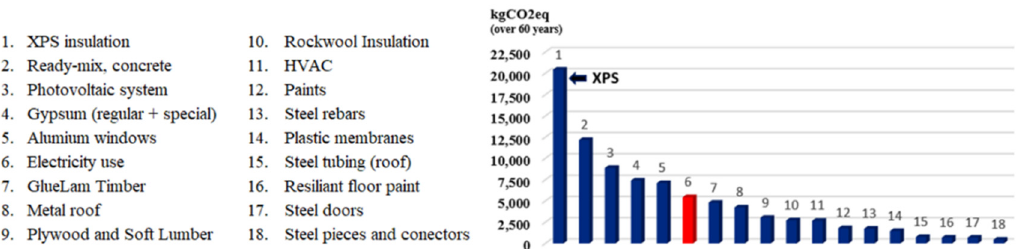
Figure 7. Life Cycle GWP contribution by material type (and energy use, in red), for baseline scenario, using One Click LCA.